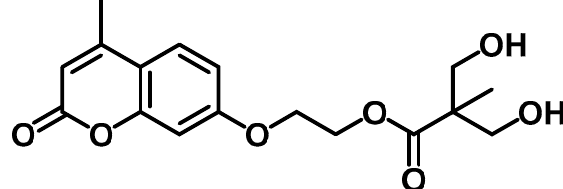
Figure 2. Stress–strain curves for coumarin-functionalised polyurethane: Non-irradiated, irradiated at 354 nm, irradiated at 354 nm and 254 nm, and irradiated again at 354 nm. Reprinted with permission from [107] ( © 2016, MDPI).